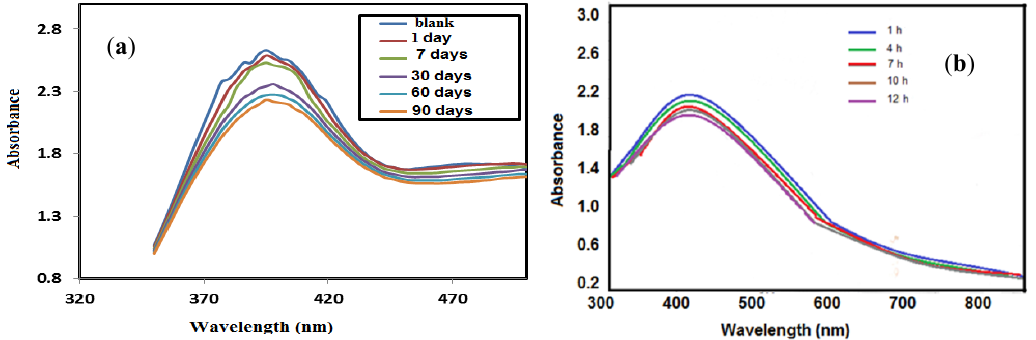
Figure 6. UV-Vis absorption spectra of Ag/PVA-SH at interval times in ( a ) SSF (0.5 M and 0.4 M glycine) and ( b ) 1 M HCl and 0.4 M glycine.